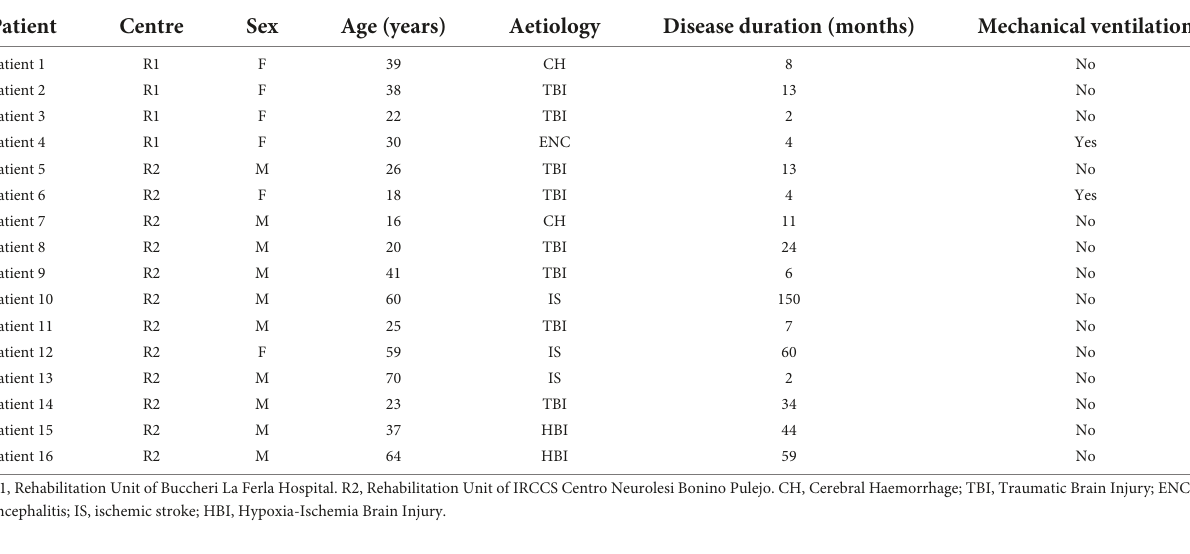
TABLE 1 Clinical and demographic characteristics of the recruited patients.